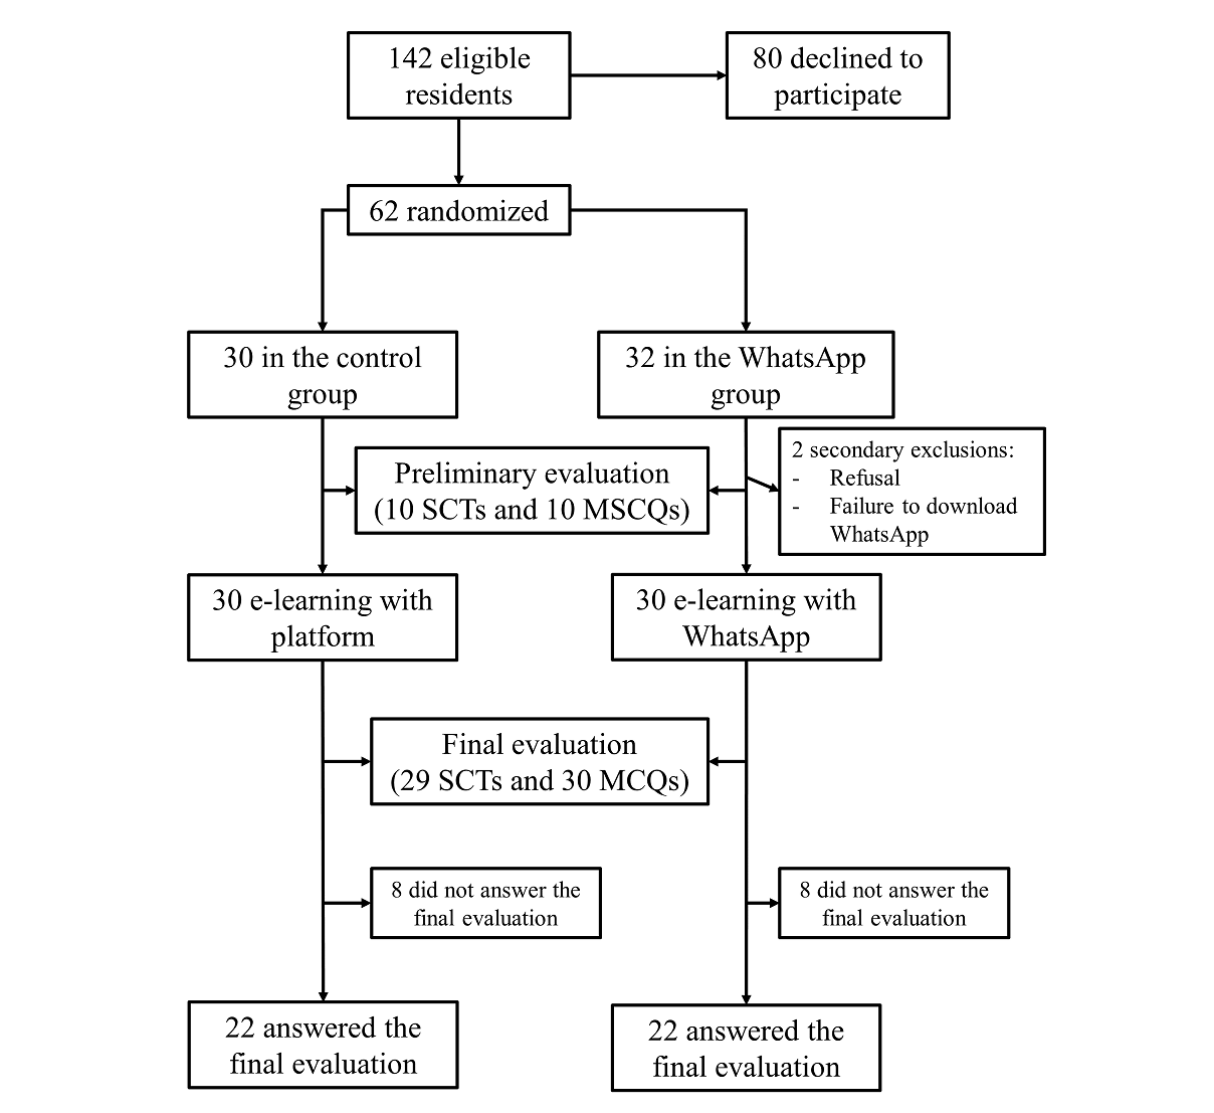
Figure 1. Flowchart of the study. e-learning: electronic learning; MCQ: multiple-choice question; SCT: script concordance